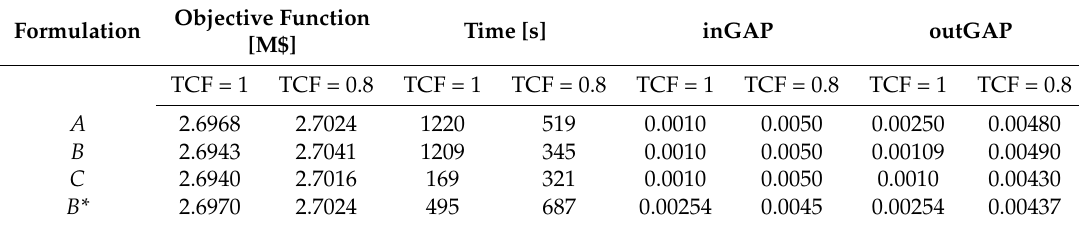
Table 2. Results obtained for different formulations of the SCUC